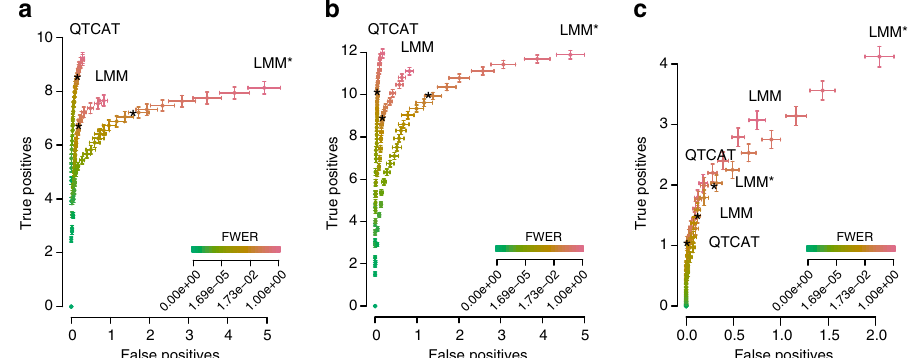
Figure 2 | True-positive versus false-positive loci at different a -levels for three different association methods. Each plot is generated on the basis of simulations with 100 replicates (see main text). The error bars represent s.e. The stars indicate the amount of true and false positives at an alpha level of 0.05. ( a ) Phenotype 1: results for simulations based on 50 causal loci with effects that were randomly drawn from a Gamma distribution and a heritability ( h 2 ) of 0.7. ( b ) Phenotype 2: similar simulation study as in a ; however, effects were drawn from a normal distribution. ( c ) Phenotype 3: results for simulations based on 150 causal loci with effects that were randomly drawn from a normal distribution and an h 2 of